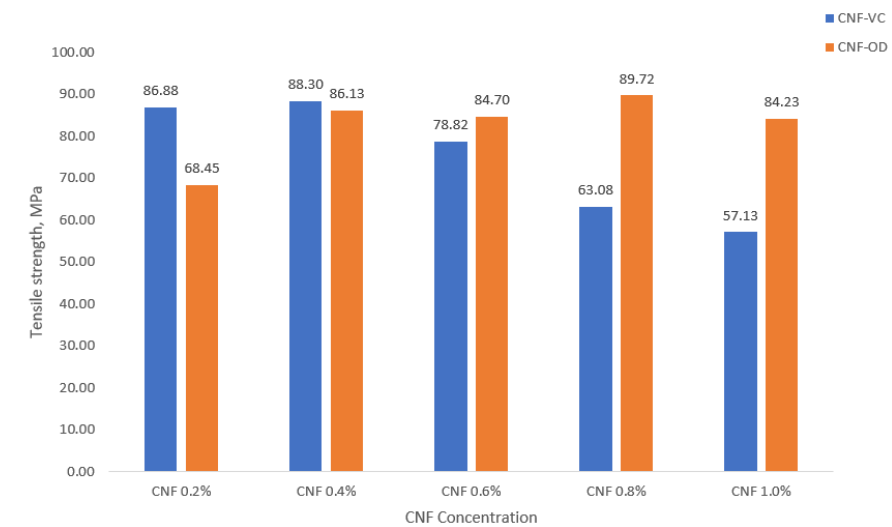
Figure 7. Tensile strength of CNF